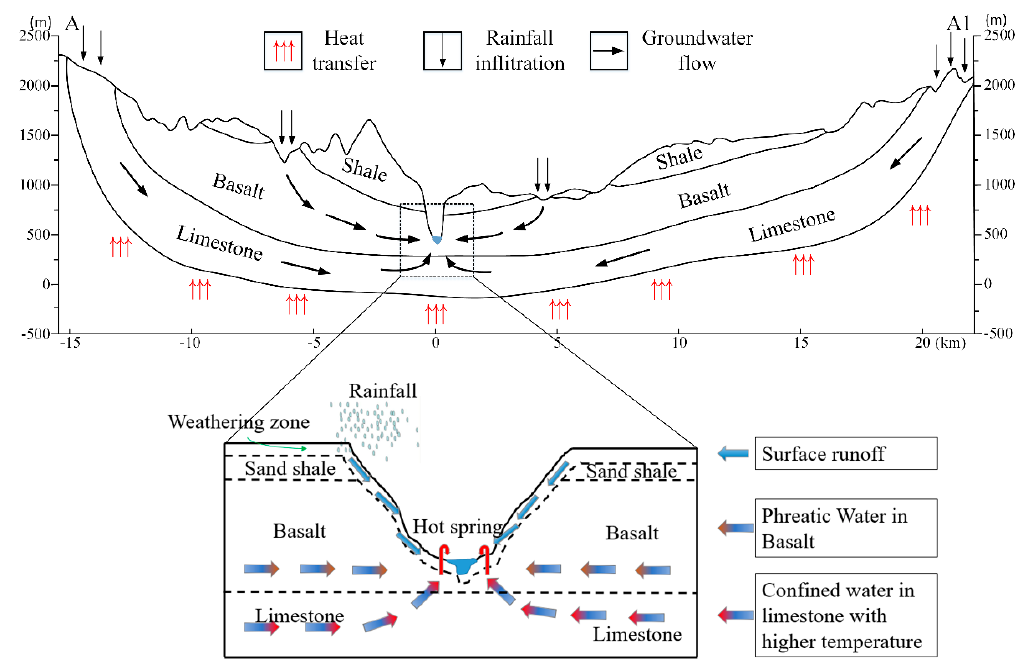
Figure 4. Schematic diagram of groundwater circulation along the A–A1 section in Figure 1.